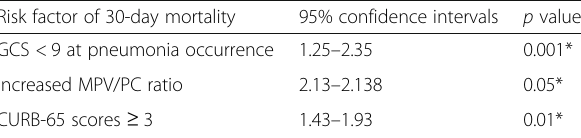
Table 5 Logistic regression analysis for detection of 30-day mortality risk in pneumonia complicating ischemic stroke patients in non-survivors Risk factor of 30-day